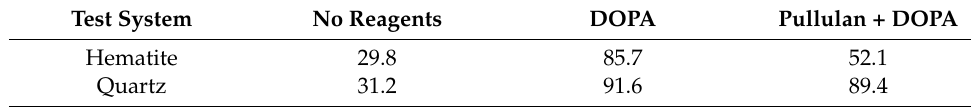
Table 1. Contact angle of two minerals with different reagents/ ◦ .